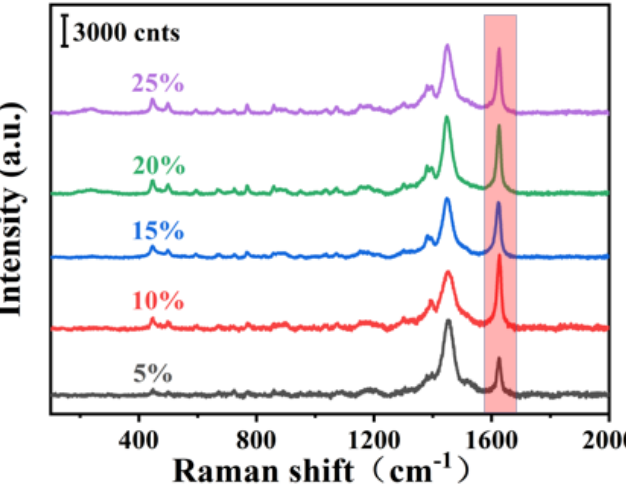
Figure 9. SERS spectra of MB (10 − 4 M) on composite films with different mass fractions of Ag 2 NCN nanorods.